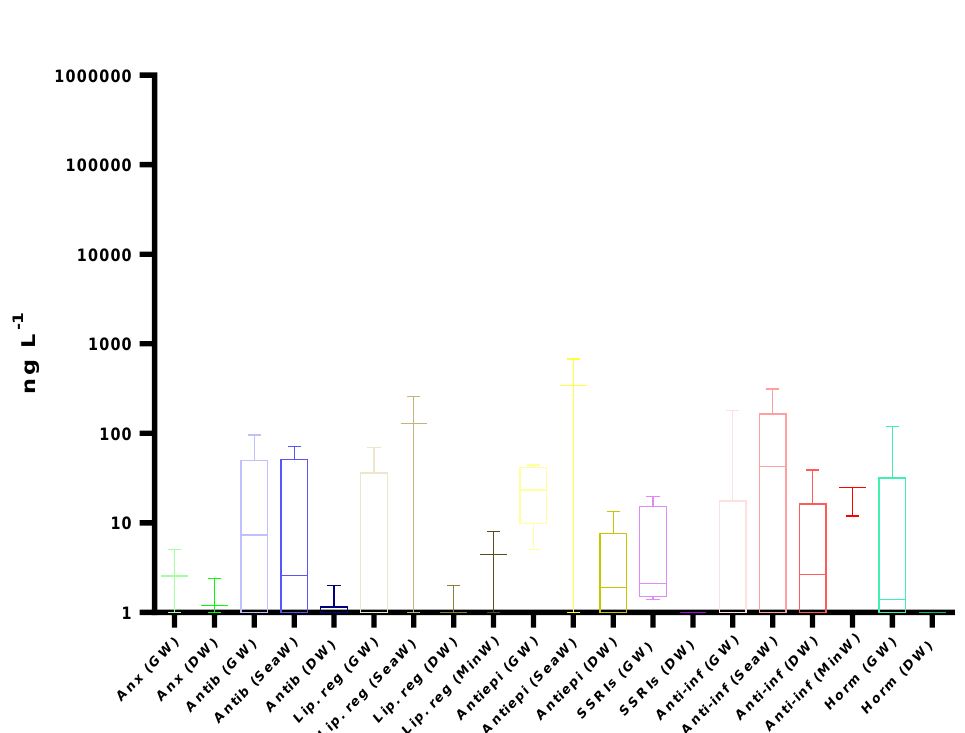
Figure 5. Boxplots with median, maximum and minimum average concentrations of pharmaceuticals in other water bodies. GW — groundwaters, SeaW — seawaters, DW — drinking waters, MinW — mineral waters, Anx — anxiolytics, Antib — antibiotics, Lip reg — lipid regulators, Antiepi — antiepileptics, SSRIs selective serotonin reuptake inhibitors, Anti-inf — anti-inflammatories, Horm — hormones and different letters represent significant statistical differences [1,6,82,91,113,128,136,141,145,166,167,174,179,189,193,200,206,209,213,215,217,225 – 231].